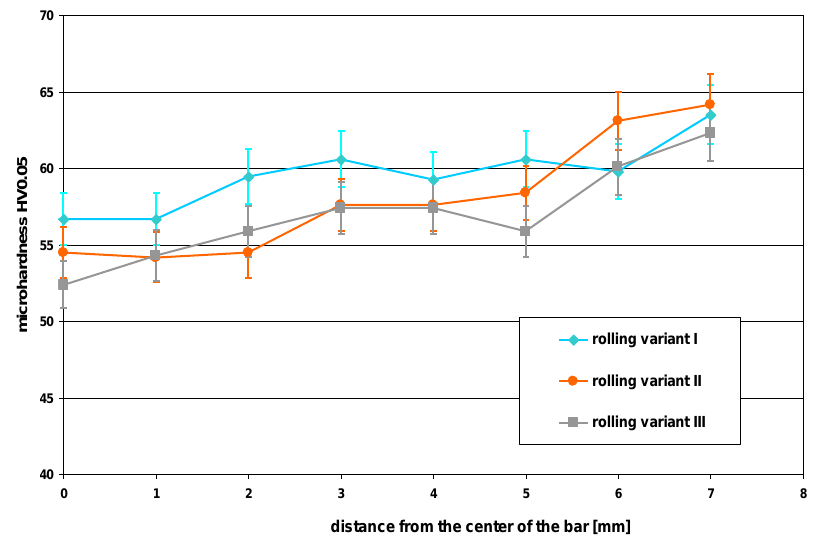
Figure 9. The change of microhardness HV 0.05 determined on the longitudinal section of rolled bars as a function of the distance from the axis of the rolled bar.